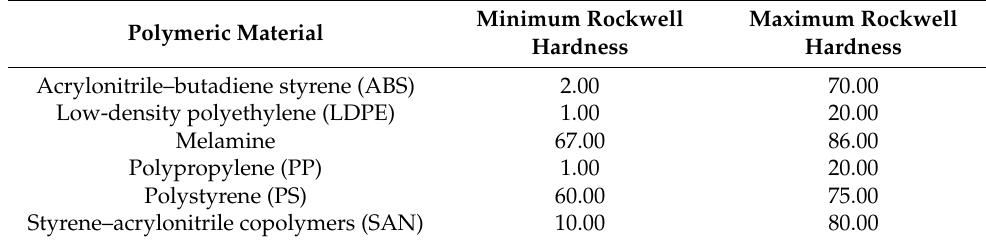
Table 1. The range of Rockwell hardness of selected